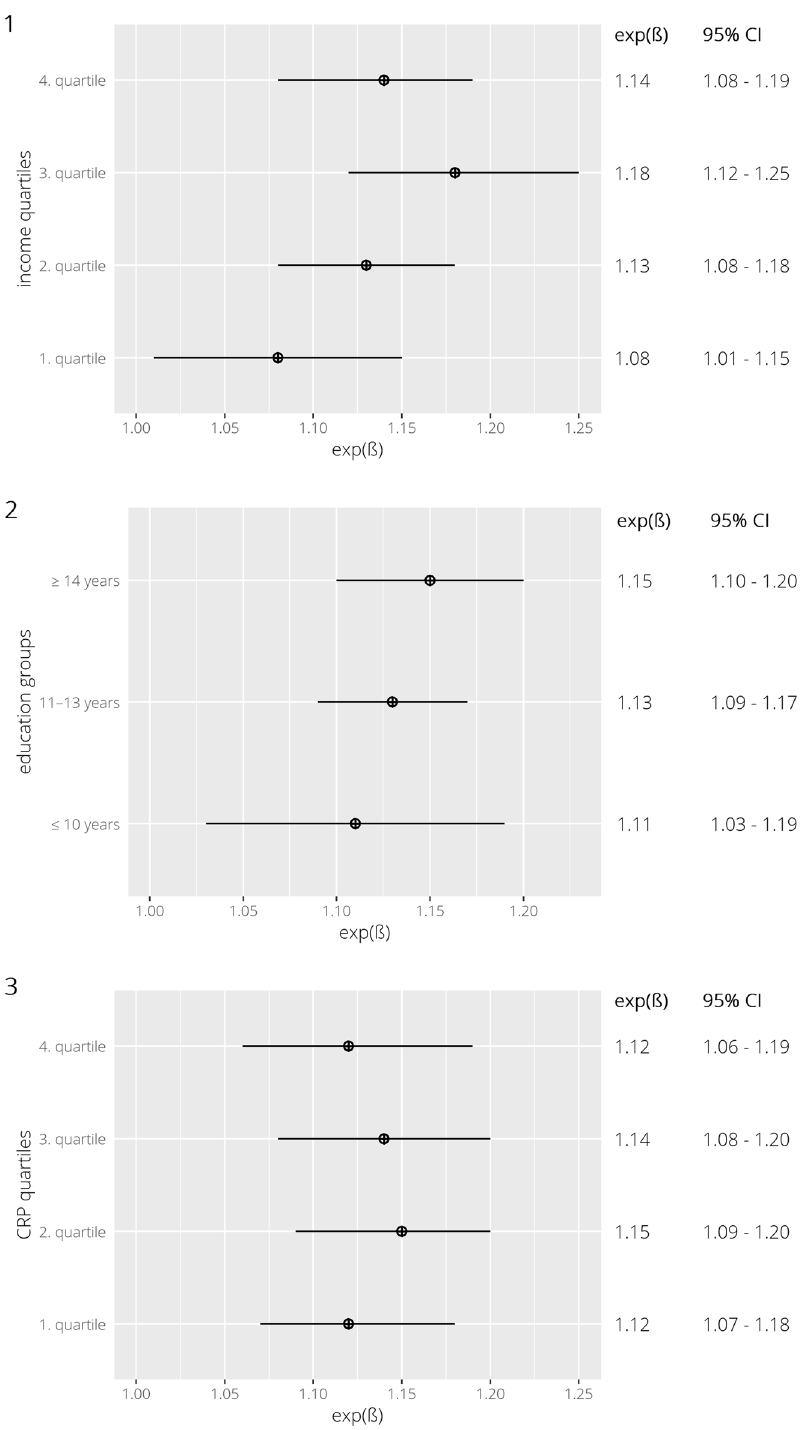
Figure 2. Exp(β) and 95% confidence intervals (95% CI) for the effect of the genetic risk allele sum score on NT-proBNP per additional effect allele stratified by income quartiles (1), education groups (2) and C-reactive protein quartiles